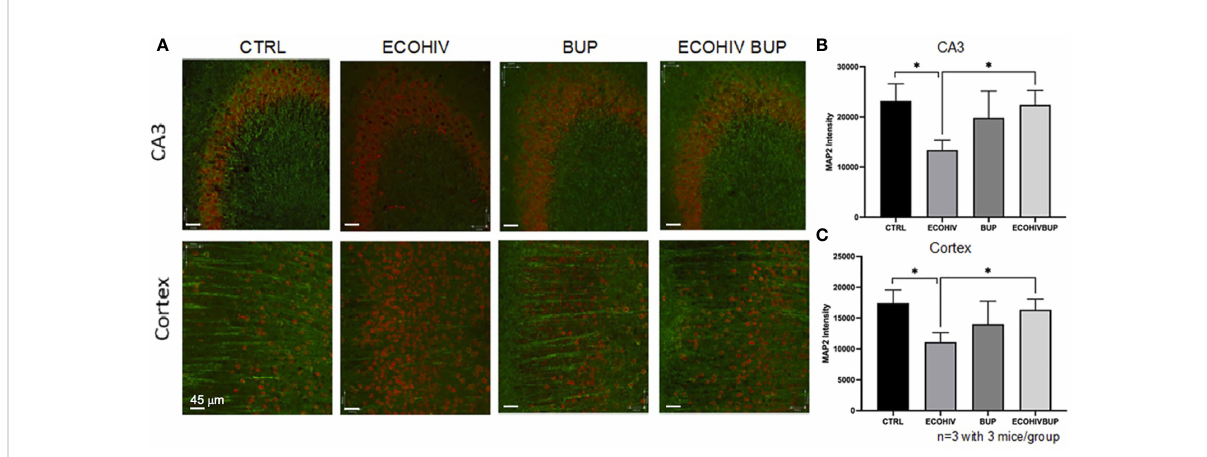
FIGURE 5 Treatment with buprenorphine protects against EcoHIV mediated synaptodendritic pruning. Brains from three mice in each group per two independent experiments were perfused, frozen, and sectioned for confocal microscopy. The mice used for these experiments were part of the approach in which buprenorphine was administered two weeks post infection. The cortex and CA3 region of the hippocampus of the brain were stained for NeuN and MAP2 to identify the neuronal cell body and dendritic processes. (A) shows representative images from these two regions from one mouse in each experimental group. The red staining de fi nes the neuronal cell body (NeuN) and the green staining de fi nes the dendritic processes (MAP2). There is a signi fi cant loss of MAP2 intensity from the CA3 region (B) and the cortex (C) of EcoHIV infected mice compared to control and compared to EcoHIV infected, buprenorphine treated mice. These results show that buprenorphine protects against EcoHIV mediated synaptodendritic